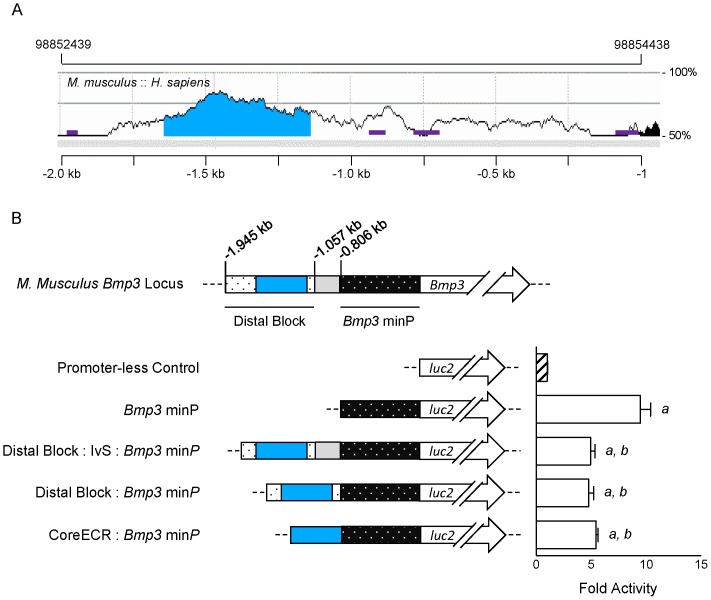
Identification of a repressive CoreECR upstream of Bmp3 between M. musculus and H. sapiens.A: Image adapted from ECR Browser aligning the regions upstream of the Bmp3 transcription start site between M. musculus and H. sapiens. Threshold was set to ≥77% identity across sliding 350 nt window. This revealed a CoreECR upstream of the annotated transcription start site of Bmp3 in both species (blue region –M. musculus: 98852797–98853301 on NC_000071.6; H. sapiens: 81949936–81950336 on NC_000004.11). Genomic coordinates refer to location on M. musculus NC_000071.6. Gray bar indicates aligned segment. Purple boxes indicate repeat elements in M. musculus. Black region indicates 5′-end of Bmp3 exon 1 in M. musculus. B: Regulation of firefly luciferase activity driven by fragments from the region upstream of M. musculus Bmp3 in HEK293T cells. minP = minimal promoter; IvS = intervening sequence between distal and proximal conserved blocks. Data are mean±SEM normalized to promoter-less control. p<0.05 as determined by One-way ANOVA with post hoc Newman-Keuls correction is indicated by “a” versus promoter-less control and by “b” versus −0.800 kb fragment.